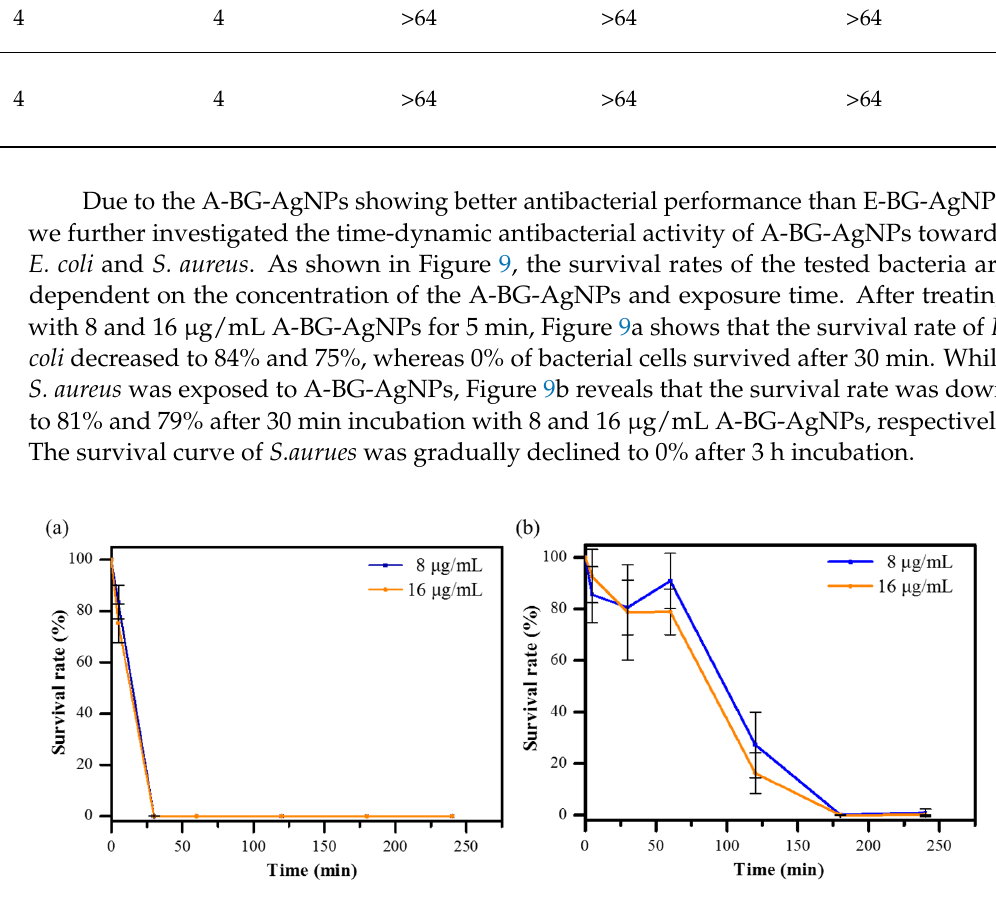
Figure 9. Time dynamic survival rate curves of ( a ) E. coli. and ( b ) S. aureus treated with different concentrations of A-BG-AgNPs ( n = 3).